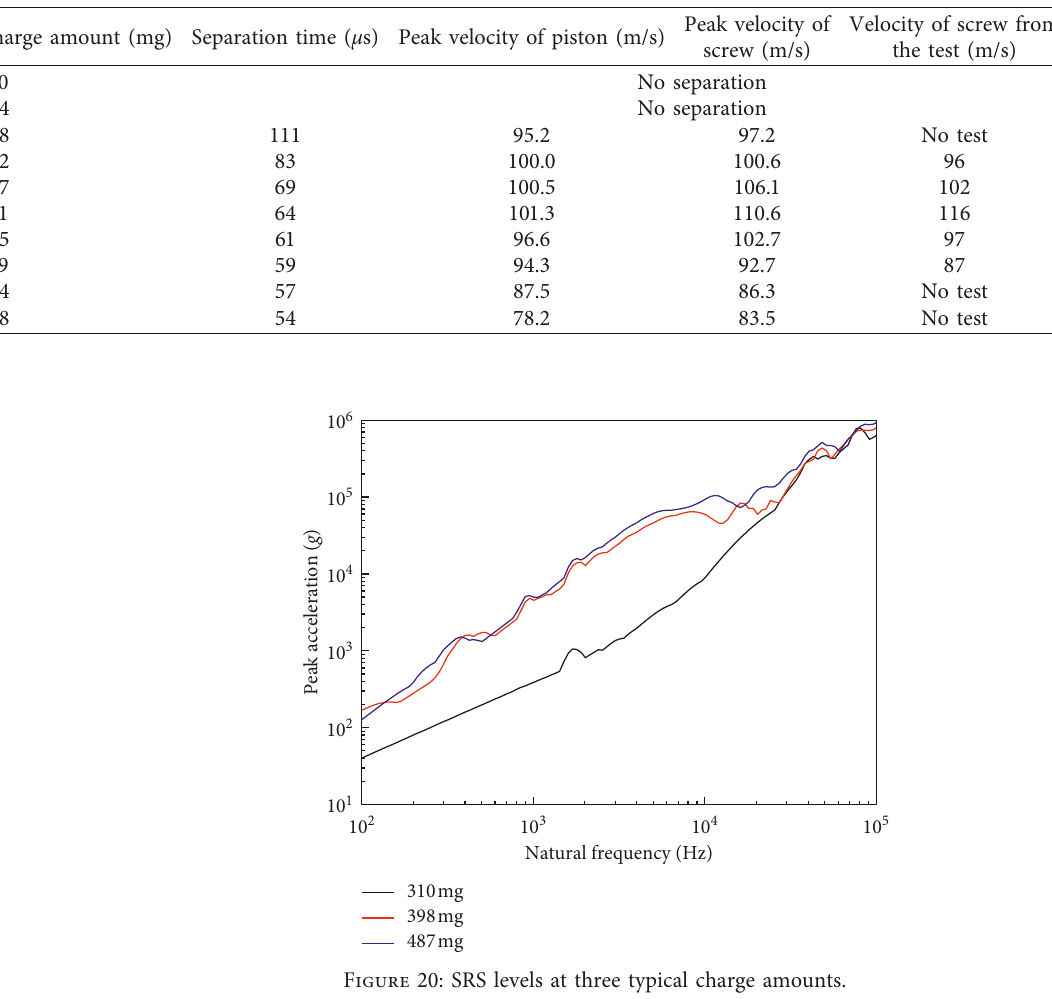
Table 4: Separation characteristics of explosive bolts under different charge amounts.